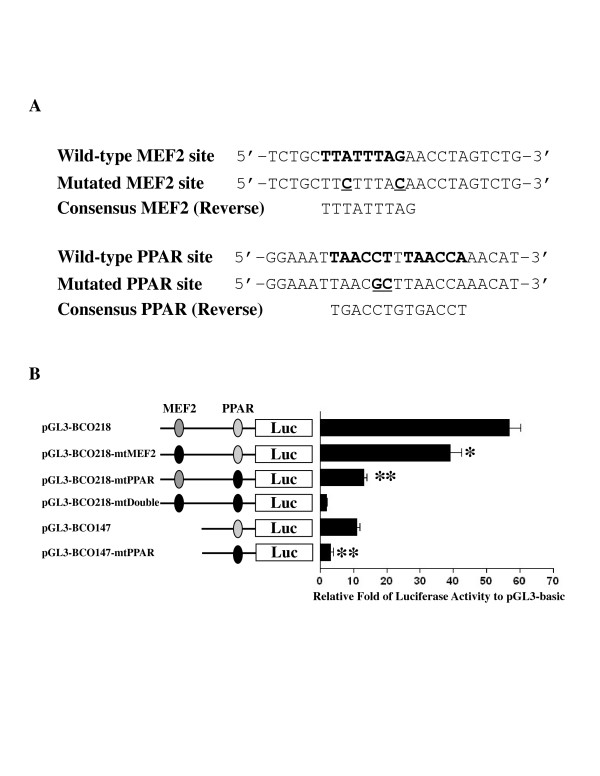
Functional analysis of the BCMO1 promoter mutated regulatory sequences. A. Comparison of wild type and mutant sequences for the BCMO1 promoter MEF2 binding site (-187/-163) and PPAR binding site (-61/-37). Mutated base pairs are underlined and in bold. B. Site-directed mutations (in solid black) were introduced into the binding sites of both MEF2 and PPAR transcription factors. TC-7 cells were transfected with 0.3 μg/well of luciferase reporter constructs containing BCMO1 proximal promoter fragments of 218 bp or 147 bp in length or with the corresponding mutated sequences. Data are expressed as a relative fold luciferase activity compared to that of the empty vector. Results shown are means ± S.D. of three or more independent experiments each performed in triplicate. *, p < 0.05, **, p < 0.001.